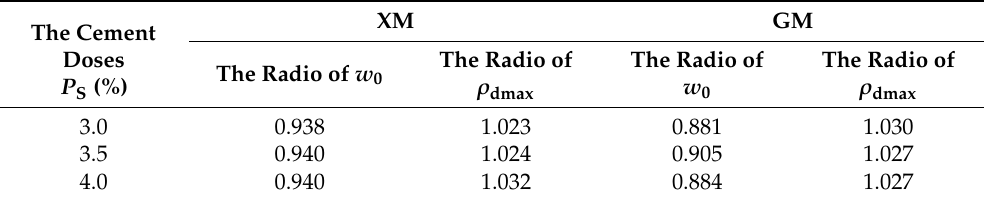
Table 8. The ratio of w 0 and ρ dmax under vibration compaction versus static pressure compaction. The Cement